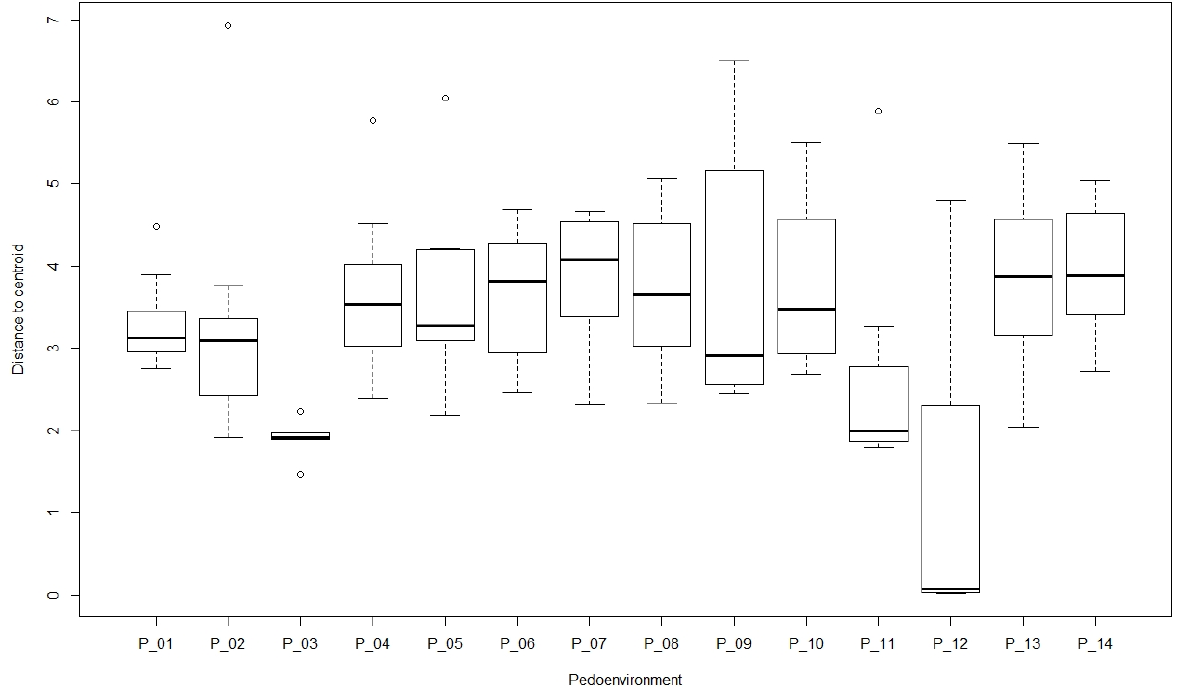
Figure 7. Differences in β-diversity measured as distance to group centroid along the pedoenvironmental gradient. Average pairwise dissimilarity is presented. Beta diversity differs significantly between the